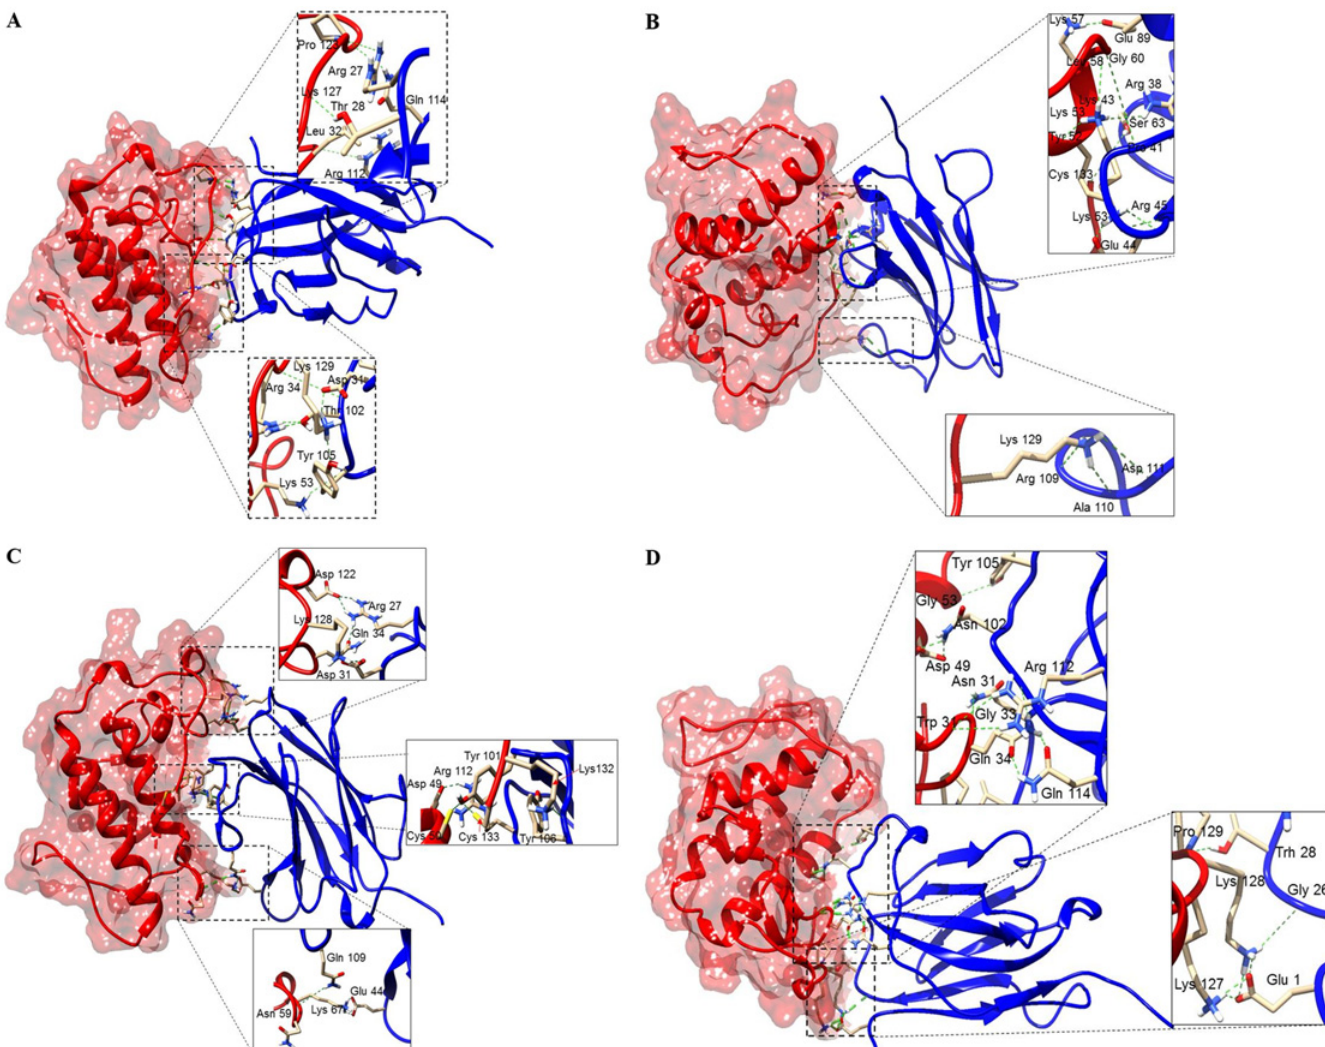
Fig 8. Docking results showing binding sites of VHHs on surfaces of PLA 2 s. (A) KF498607 (blue ribbon) and BthTX-I (red surface); (B) KC329718 (blue ribbon) and BthTX-I (red surface); (C) KF498607 (blue ribbon) and BthTX-II (orange surface); (D) KC329718 (blue ribbon) and BthTX-II (orange surface). The interaction sites were enlarged to show hydrogen bonds formed between the amino acid residues. Both VHHs covered the enzymatic groove surface areas of the modeled BthTX-II and inserted the CDR3 into the catalytic cleft, as well as being able to interact with amino acid residues of the PLA 2 C-termini.